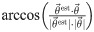
An agent flies inside the sphere on a circular trajectory (see Fig 3A).The center of the circle does not coincide with the center of the sphere to avoid symmetries in the depth model. The correct depth model is constant in this configuration, only the initialization of the depth model is tested. The y-axis shows the angle error arccos(θ→est⋅θ→∣θ→est∣⋅∣θ→∣), between the estimated self-motion axis of θ→est and the axis of the true self-motion values θ→. The depth model is initialized with constant distances. With every update step of the depth model the error decreases exponentially for the translation (blue) as well as for the rotation (red).